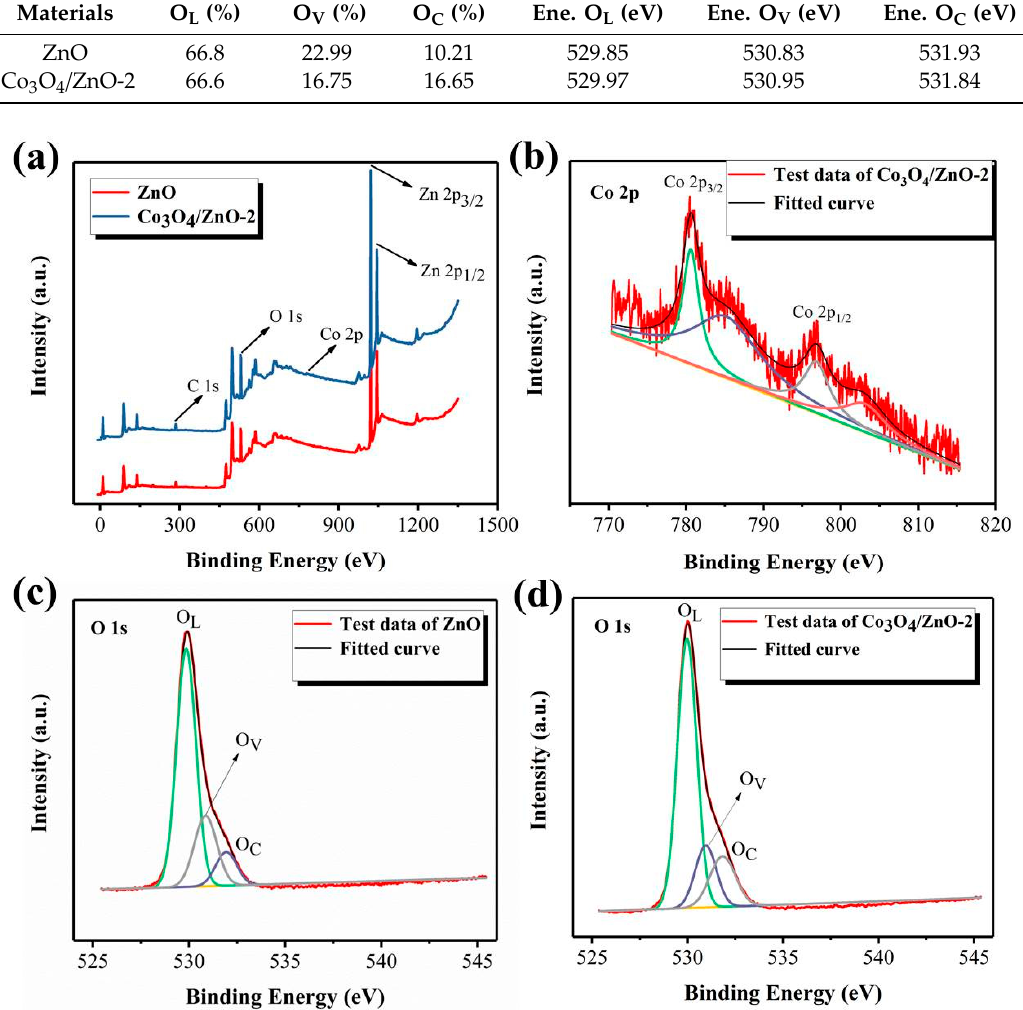
Figure 5. X-ray photoelectron spectroscopy spectra of ZnO and Co 3 O 4 / ZnO-2: ( a ) The full spectra, ( b ) Co 2p spectrum of Co 3 O 4 / ZnO-2, ( c , d ) O 1s spectra of the ZnO and Co 3 O 4 /ZnO-2.